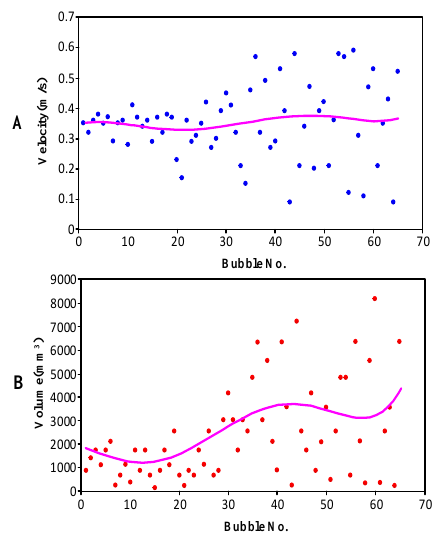
Figure 12. Velocity and volume scatter diagrams for the same group of bubbles. ( A ) The velocity scatter diagram; ( B ) the volume scatter diagram. In Figure 12A, the velocity of the bubbles is concentrated when the bubble number is within 30, but then it begins to diffuse quickly. In addition, the velocity is the same as the volume (as shown in Figure 12B) for the same group of bubbles. That is to say, the bubbles’ velocities and volumes began to diffuse quickly after bubble number 30. We reached the following conclusions from this phenomenon. 1. The phenomenon was caused by the mutation of the two-phase flow. It may have been the pressure mutations of the coal seam, coalbed water increase, or other geological cause. In short, the condition of the down hole was unstable, and it is therefore better not to adjust the gas drainage and extraction processes during this period. 2. The range of the velocity and volume get bigger, and the average velocity and average volume have an increasing trend.